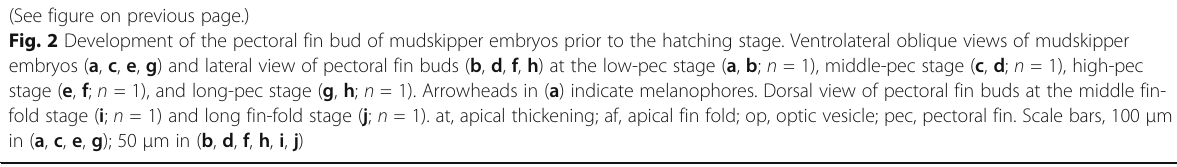
heart shape (Additional file 1: Figure S1S, S ′ ). Both the dor- sal median fin fold and the ventral median fin fold begin to narrow in the caudal region (arrows in Additional file 1: Figure S1T). In a cross-section of the pectoral fin bud, cuboidal chondrogenic cells are seen to align to form a single-cell-layered endoskeletal disc in the center of the pectoral fin bud (Fig. 3e, f).